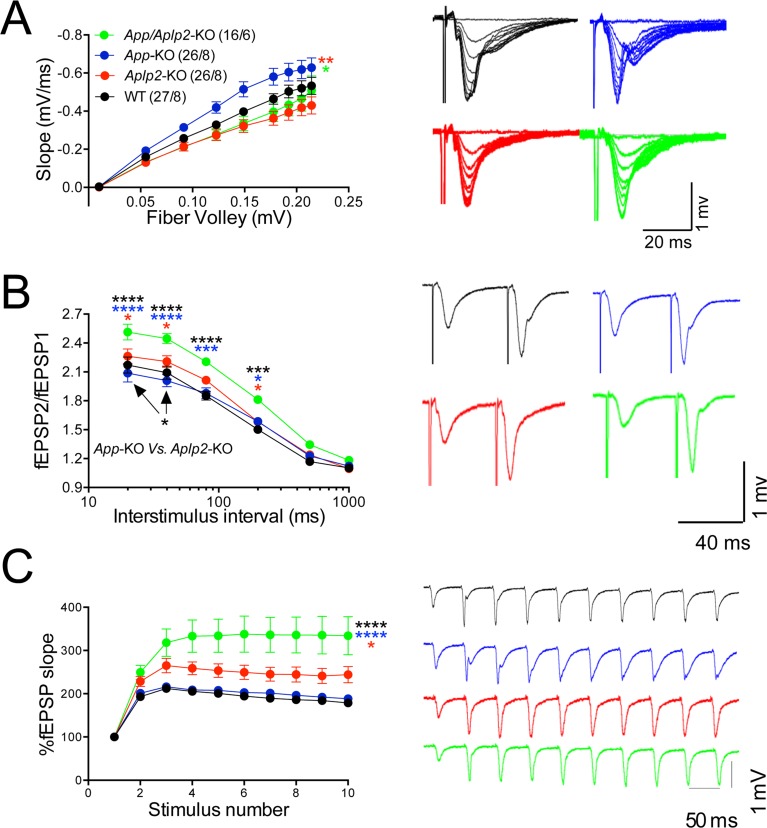
Amyloid precursor protein (APP) like protein-2 (APLP2) compensates for loss of APP function.(A) Input/output (I/O) recording showed significant differences between different genotypes (App-KO vs. Aplp2-KO, **p < 0.01; App-KO vs. App/Aplp2-dKO, *p < 0.05). PPR (B) and frequency facilitation (FF) (C) are significantly increased in App/Aplp2-dKO as compared to all other genotypes. Representative traces are shown on the right of summary plots. The number of recordings and of mice analyzed for each group are shown in (A). Statistical assessment by two-way repeated measures analysis of variance (RM ANOVA) followed by Tukey’s multiple comparisons tests. All data represent means ± SEM (*p < 0.05; **p < 0.01; ***p < 0.001).DOI:
http://dx.doi.org/10.7554/eLife.09743.03110.7554/eLife.09743.032Figure 11—source data 1.Source data for statistical analysis of input/output curves in Figure 11A.DOI:
http://dx.doi.org/10.7554/eLife.09743.03210.7554/eLife.09743.033Figure 11—source data 2.Source data for statistical analysis of paired-pulse facilitation in Figure 11B.DOI:
http://dx.doi.org/10.7554/eLife.09743.03310.7554/eLife.09743.034Figure 11—source data 3.Source data for statistical analysis of frequency facilitation at 20Hz in Figure 11C.